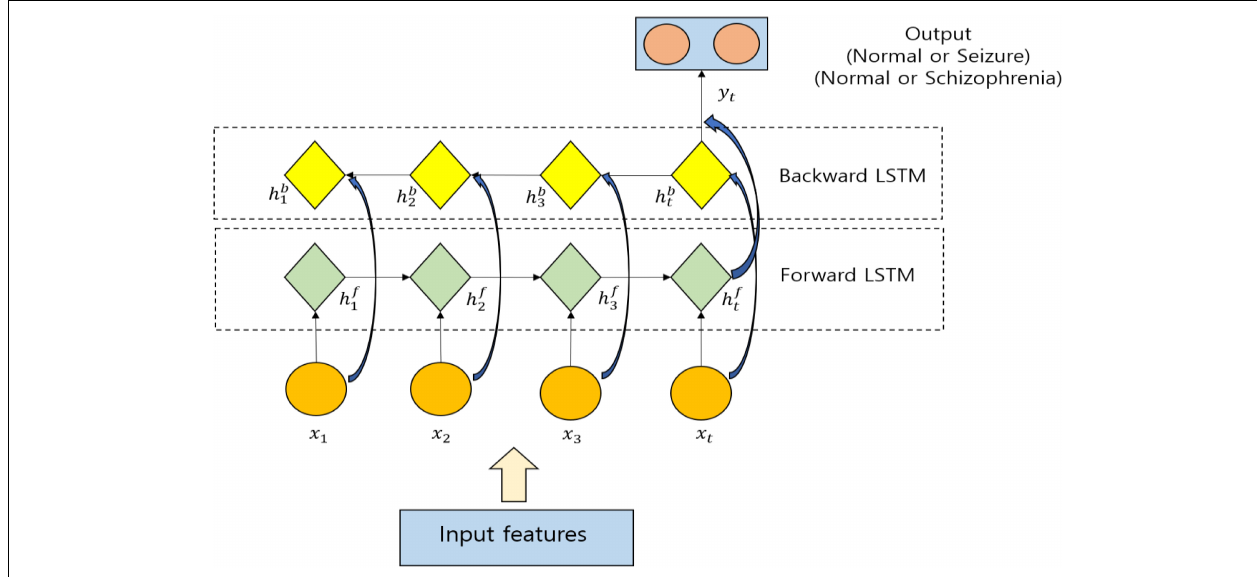
FIGURE 4 | Utilization of Bi-Long Short-Term Memory (LSTM) for classification.